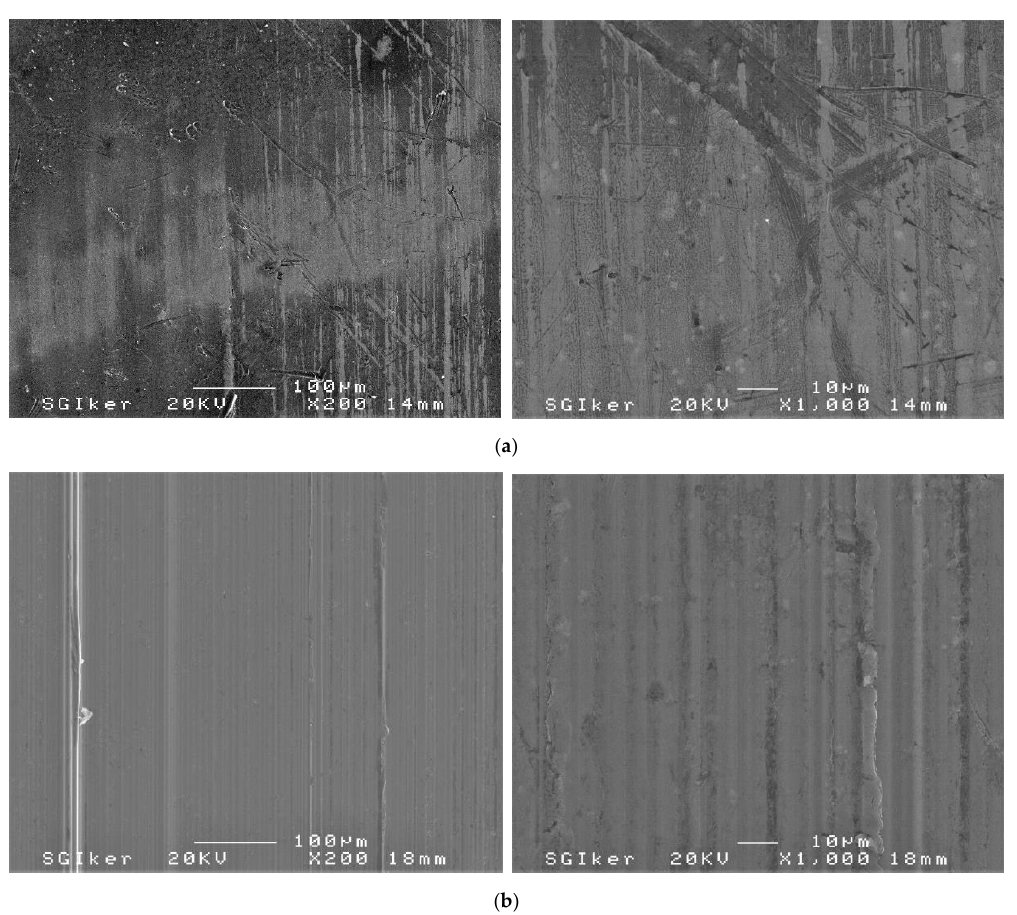
Figure 9. SEM micrographs that show wear in the AA5083-N2-T200 cam after 200 × 10 3 rev: ( a ) upper zone; ( b ) lower zone. zone; ( b ) lower